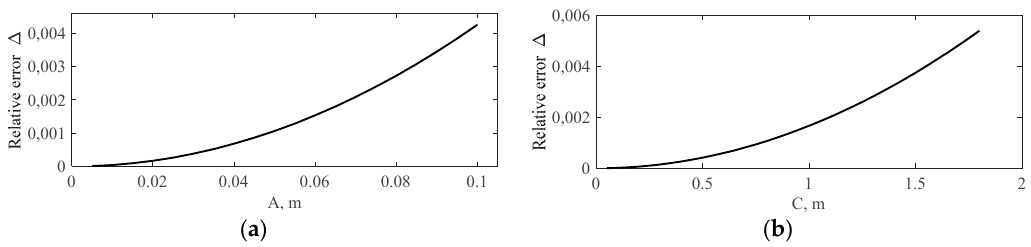
Figure 10. Relative error in the function: ( a ) of the amplitude A of oscillation at the λ = 5m and L = 40m; ( b ) of the deviation C at the A = 0 and L = 40m.